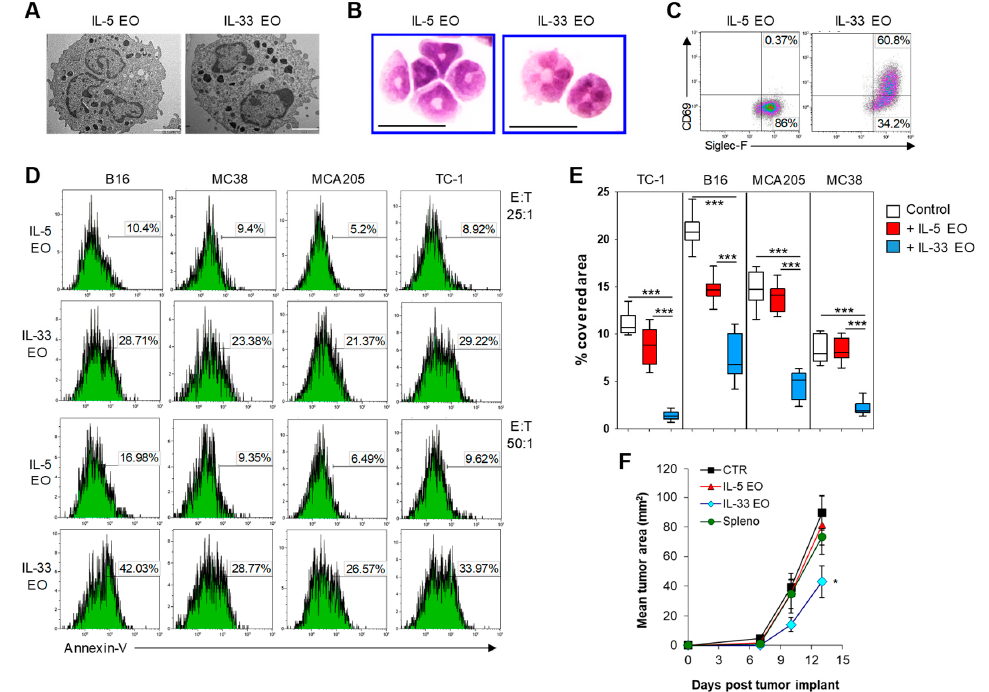
Figure 2. IL-33 directly activates eosinophils and promotes tumoricidal activity. ( A ) Representative electron micrographs of bone marrow-derived eosinophils classically di ff erentiated with IL-5 (IL-5 EO) or terminally activated with IL-33 (IL-33 EO). In both eosinophils, typical granules containing electron-dense crystals were visible. ( B ) Morphology of IL-5 or IL-33-activated eosinophils. Cytospins were prepared and eosinophils were stained with hematoxylin / eosin. Bars represent 10 µ m. ( C ) Flow cytometry analysis of CD69 and Siglec-F expression in IL-33 EO and IL-5 EO. ( D ) Induction of tumor apoptosis by IL-5 vs. IL-33 EO on the indicated tumor cell lines after co-culture at the indicated E:T ratios. ( E ) IL-5 EO and IL-33 EO were co-cultured with TC-1, B16, MCA205 or MC38 tumor cells then washed out and adherent tumor cells were stained with Crystal Violet. Quantitative analysis of the tumor-covered area in the indicated culturing conditions is shown. Data are represented as fraction of area occupied by the indicated tumor cells with respect to the total field area. Mean values ± SD from 10 di ff erent microphotographs per condition are shown. *** p < 0.001. ( F ) EO tumoricidal activity in vivo. IL-5 EO or IL-33 EO were co-injected with B16.F10 melanoma cells subcutaneously into syngeneic C57Bl / 6 mice. Control groups consisted of mice receiving B16 cells alone (CTR) or B16 cells plus splenocytes from naïve mice (Spleno). Tumor growth was measured. Mean tumor area ± SEM of 10 mice from 2 independent experiments is shown. * p <